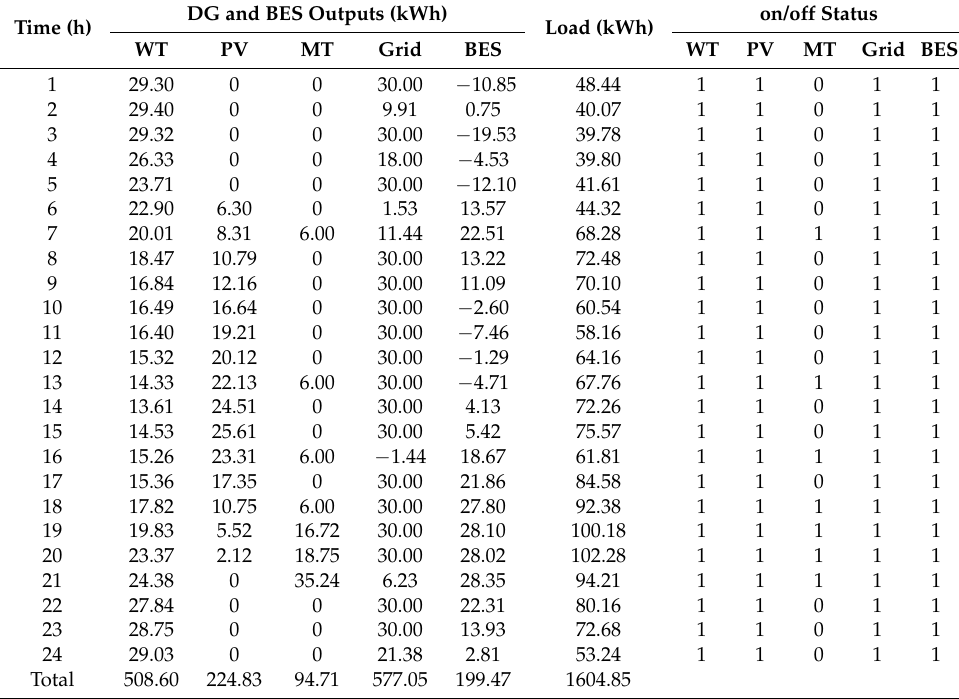
Table 4. Results of Scenario 2 (total cost = 422.90